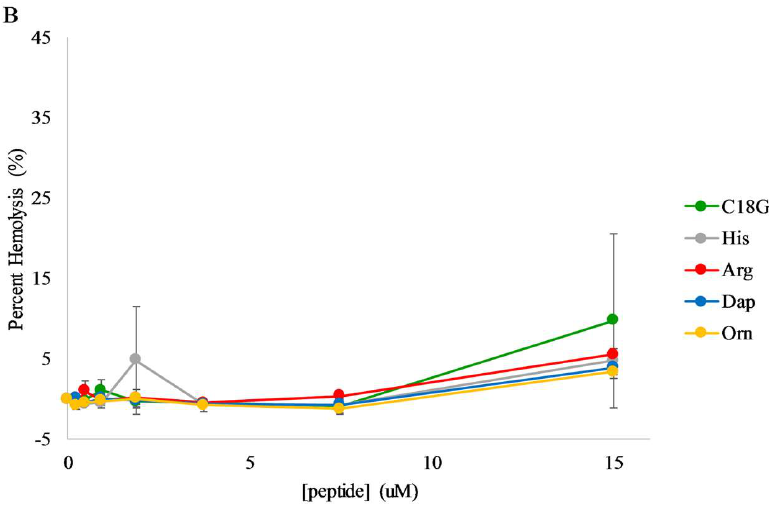
Figure 5. Membrane permeabilization. ( A ) Permeabilization of S. aureus membranes by peptides. Cultures of S. aureus were incubated with varying concentrations of peptide and 3.75 µ g/mL propidium iodide (PI). PI fluorescence was measured via flow cytometry after 30 min of exposure to peptides. Percent leakage was determined based on the positive control CTAB (data not